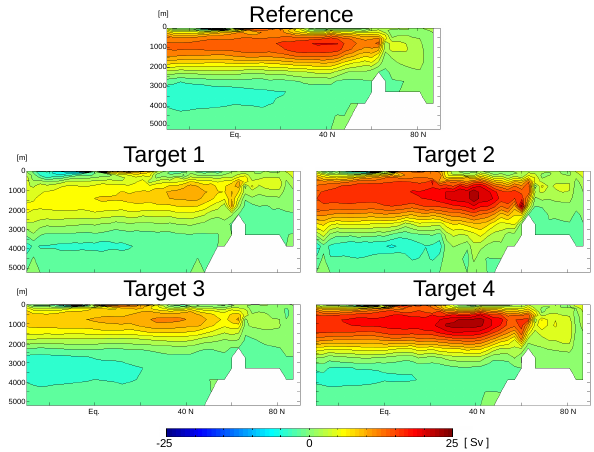
Fig. 1. Stream function of the Atlantic meridional overturning cir- culation for the reference state and the four